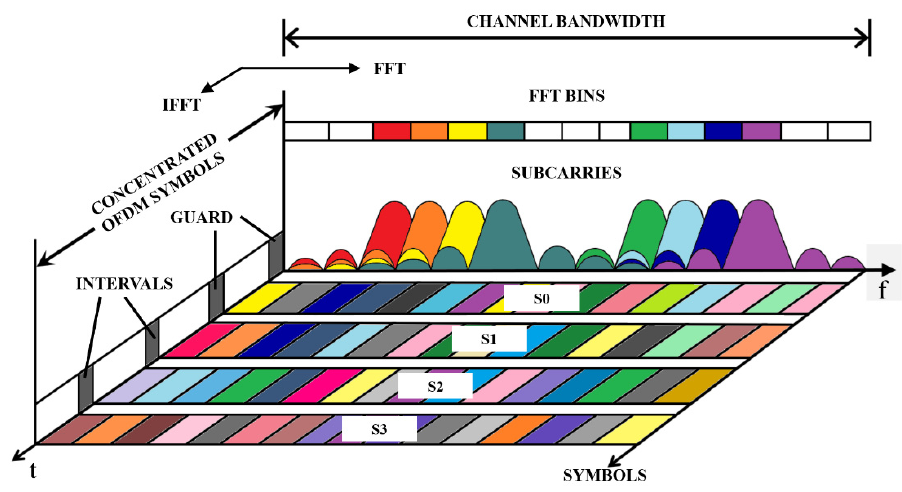
Figure 3. Representation of OFDM signal in frequency–time domain (based on [13]).